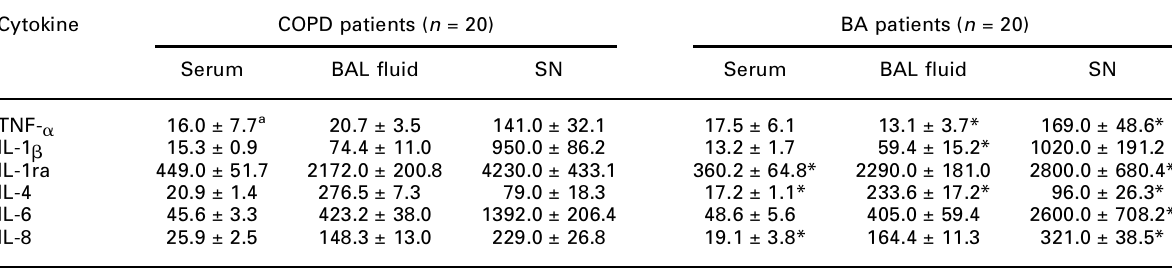
Table 2. Concentrations (pg/ml) of chosen cytokines in the serum, the BAL fluid and in the supernatants (SN) of PBMC cultures from COPD and BA patients Cytokine COPD patients ( n =